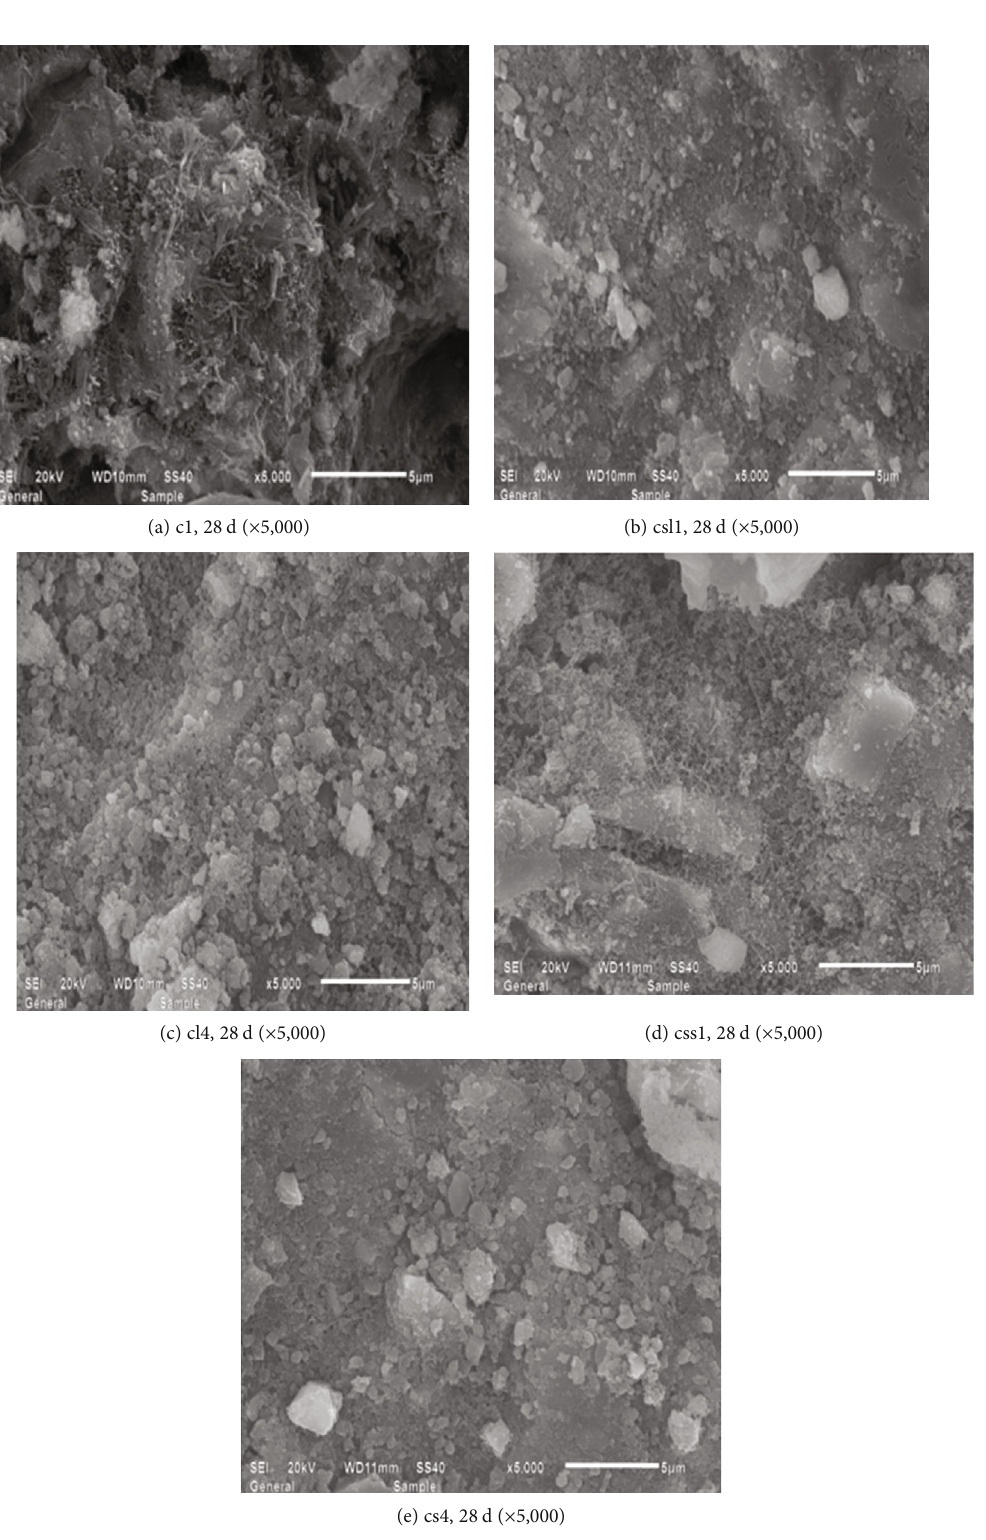
Figure 8: The 28d SEM